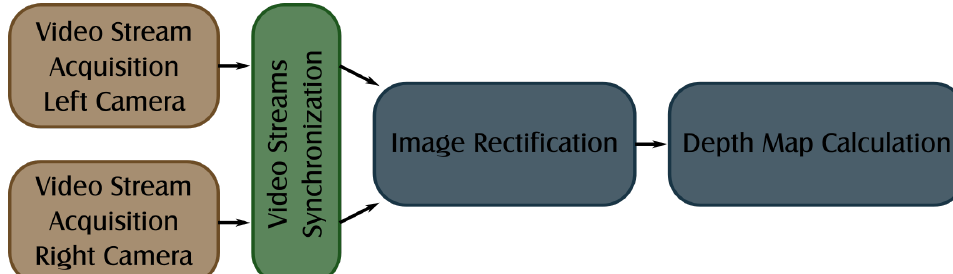
Figure 2. Disparity map calculation